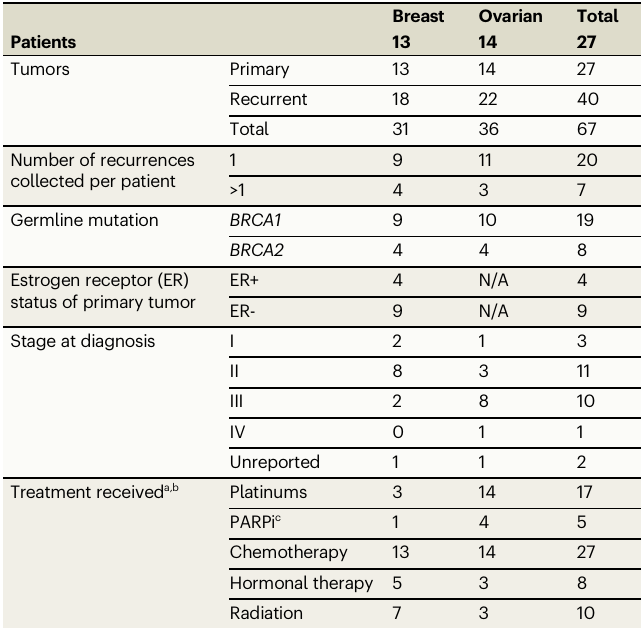
Table 1 | Characteristics of primary/recurrent patient cohort and tumors